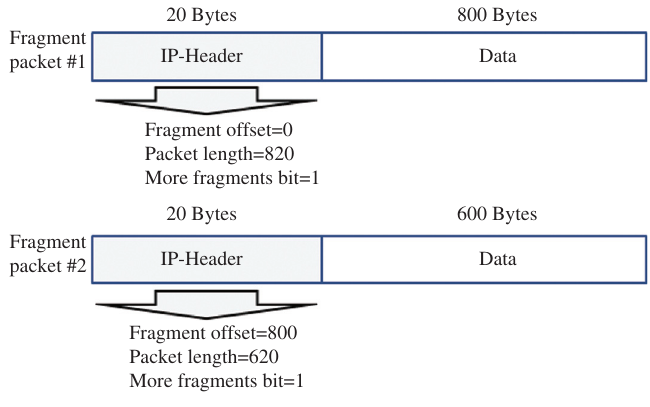
Figure 3. The Teardrop